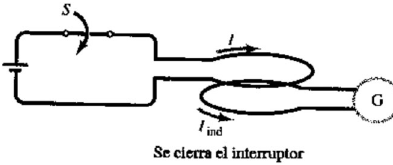
FIG. 6. The switch S of the circuit with a battery is closing.